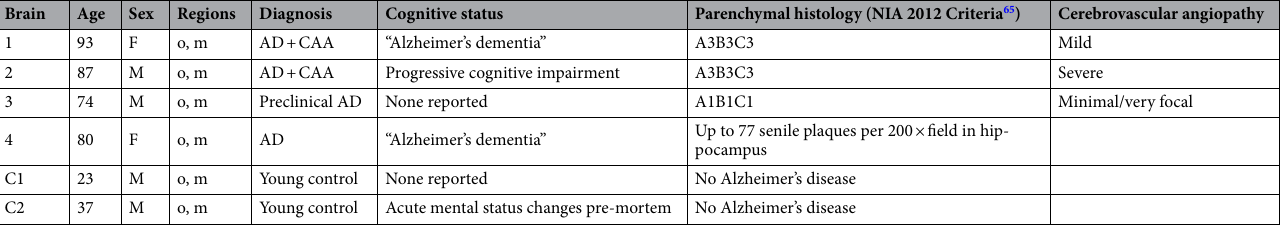
Table 1. Summary of characteristics of brains examined. Regions: ‘o’ = occipital, ‘m’ =